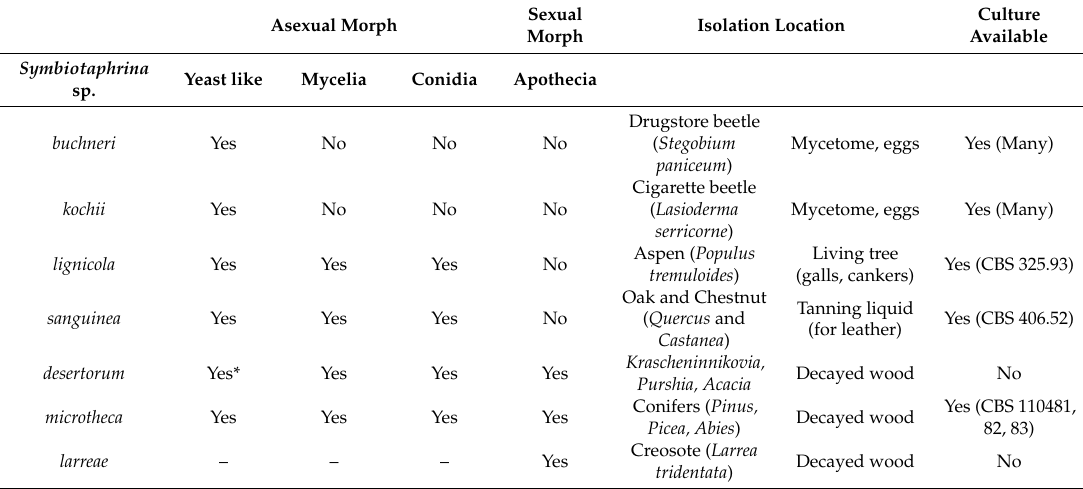
Table 3. Sexual reproduction di ff erences among Symbiotaphrina species. Asexual Morph